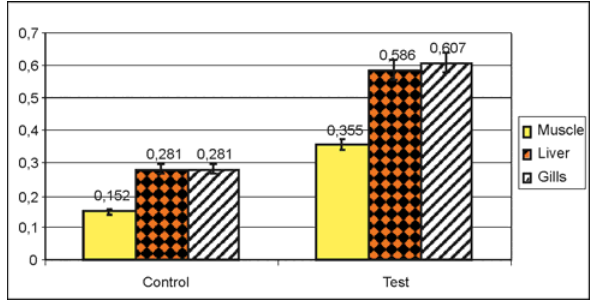
Fig. 12. Chromium concentration (mg/kg) in tissues of stone loach